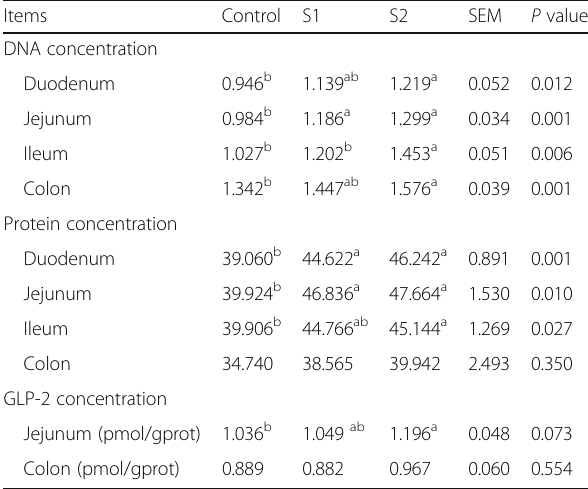
Table 5 Effect of SCFA on DNA, protein, and GLP-2 concentration of mucosa in duodenum, jejunum, ileum, and colon of weaned piglets ( μ g/mg)